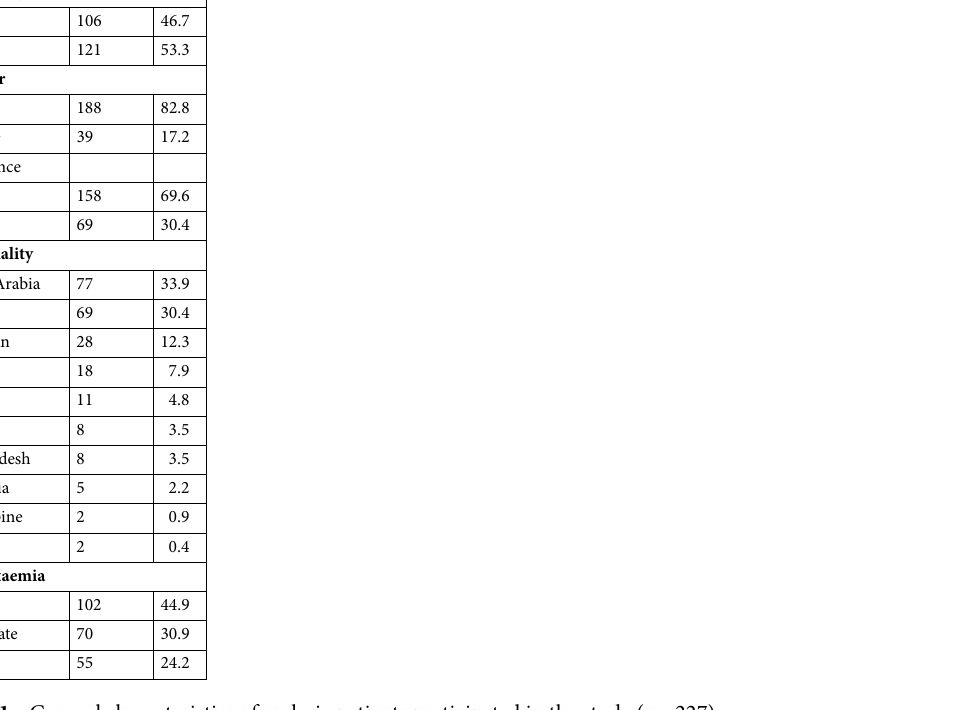
Table 1. General characteristics of malaria patients participated in the study (n =